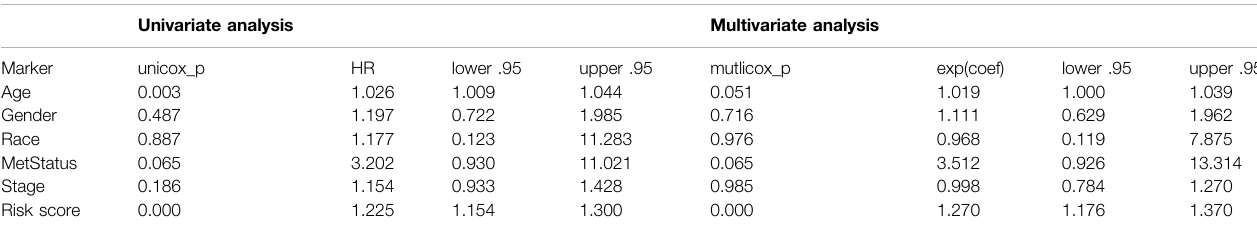
TABLE 3 | Univariate and multivariate Cox regression analyses of 11 mRNAsi-related genes signature and clinical variables associated with overall survival in subtype 2 datasets. Univariate analysis Multivariate analysis